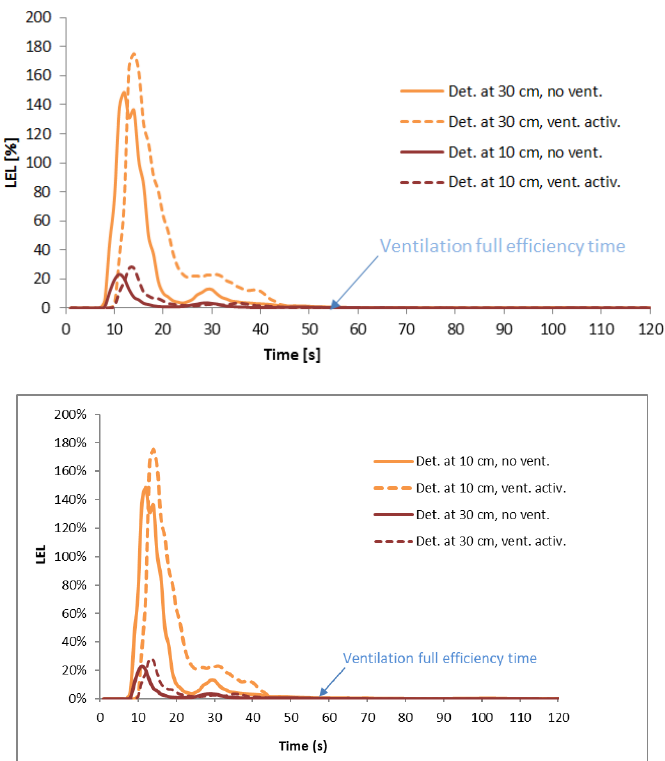
Figure 13. LPG concentration 3 m from emission source with 6-mm gap (measurement point No. 3L).